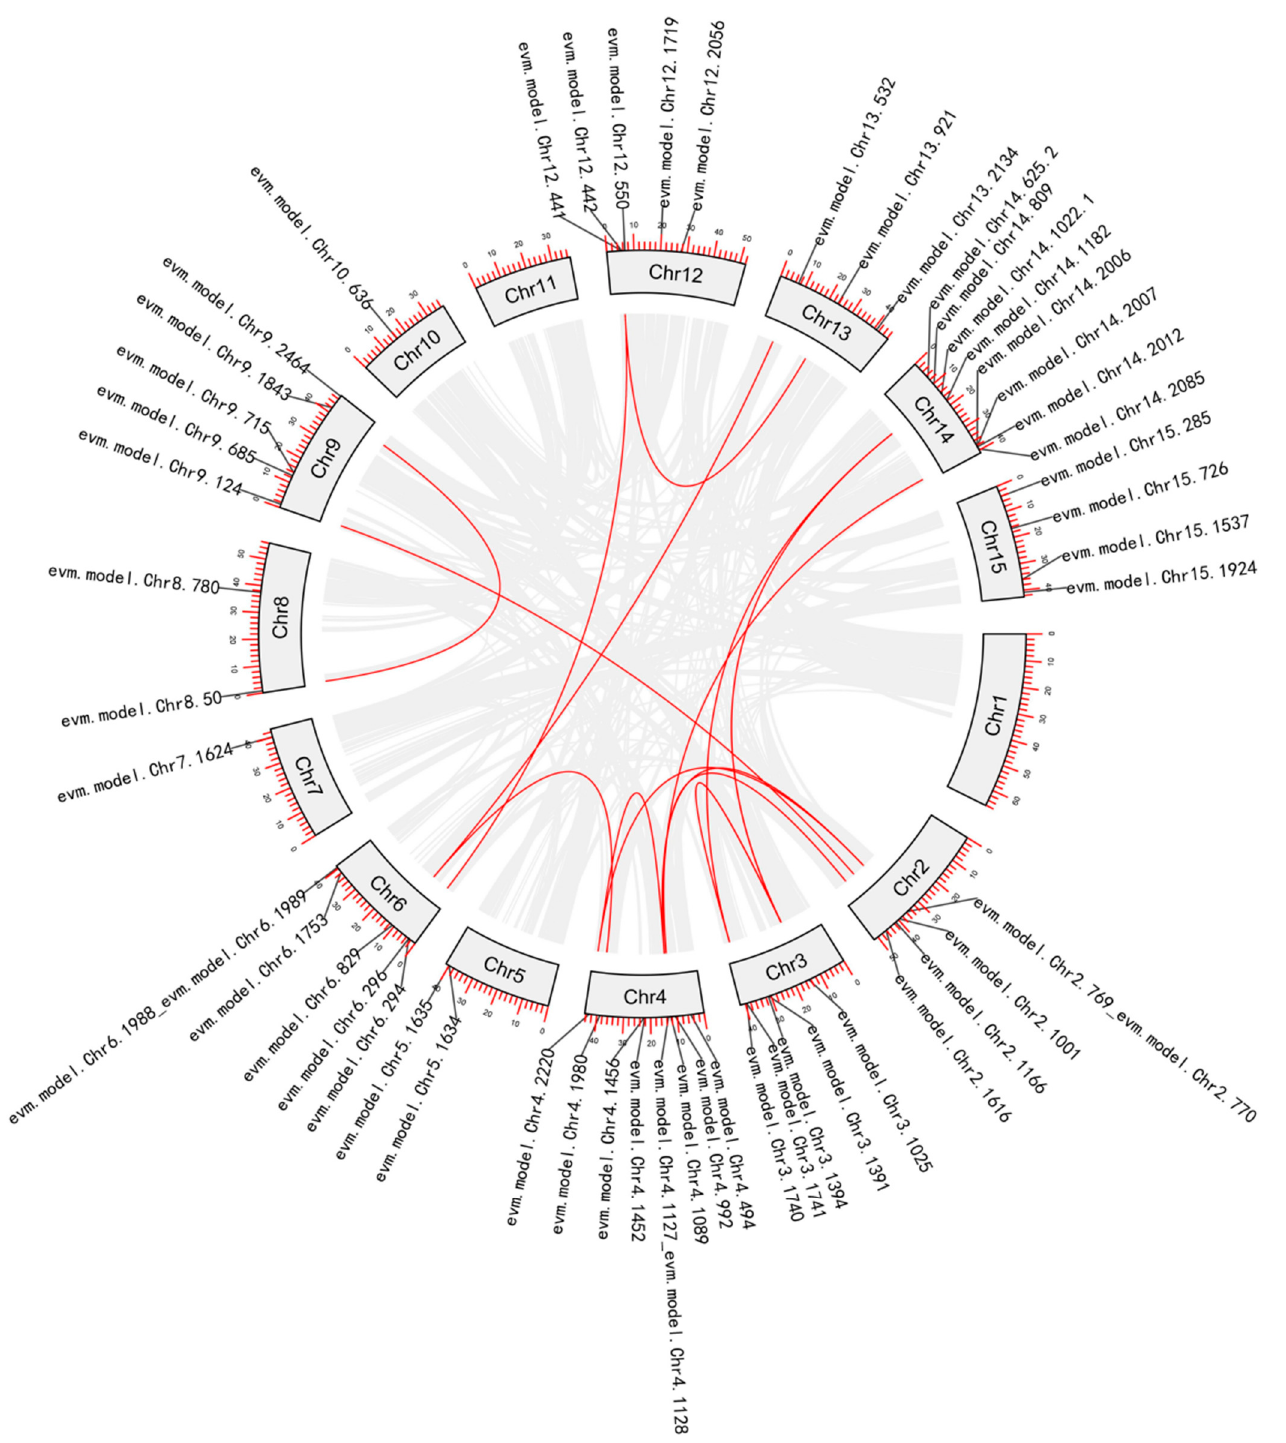
Figure 2. Distribution and duplication of DolMADS s. Gray lines represent the chromosomes of D. oleifera . The scales on the chromosomes represent the chromosome length. The red lines indicate duplicated DolMADS gene pairs.